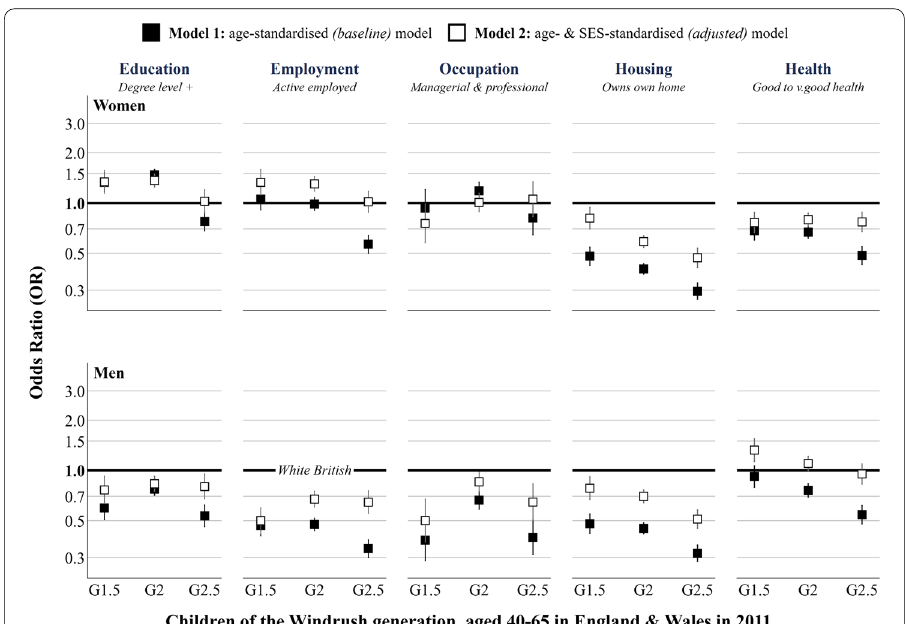
Fig. 2 Summary panel of logistic regression models for positive outcomes in the five life domains for the children of the Windrush relative to White British population resident in 2011. Notes Baseline models adjust age and subpopulation, final models adjust region of residence, civil status, level of highest qualification, NS‑SEC, housing tenure, and self‑reported general health, minus the control relating to the specific domain i.e., we do not adjust for the highest level of qualification if our outcome is having obtained a degree level Source : authors’ calculations based upon 5% microdata sample of resident population of England and